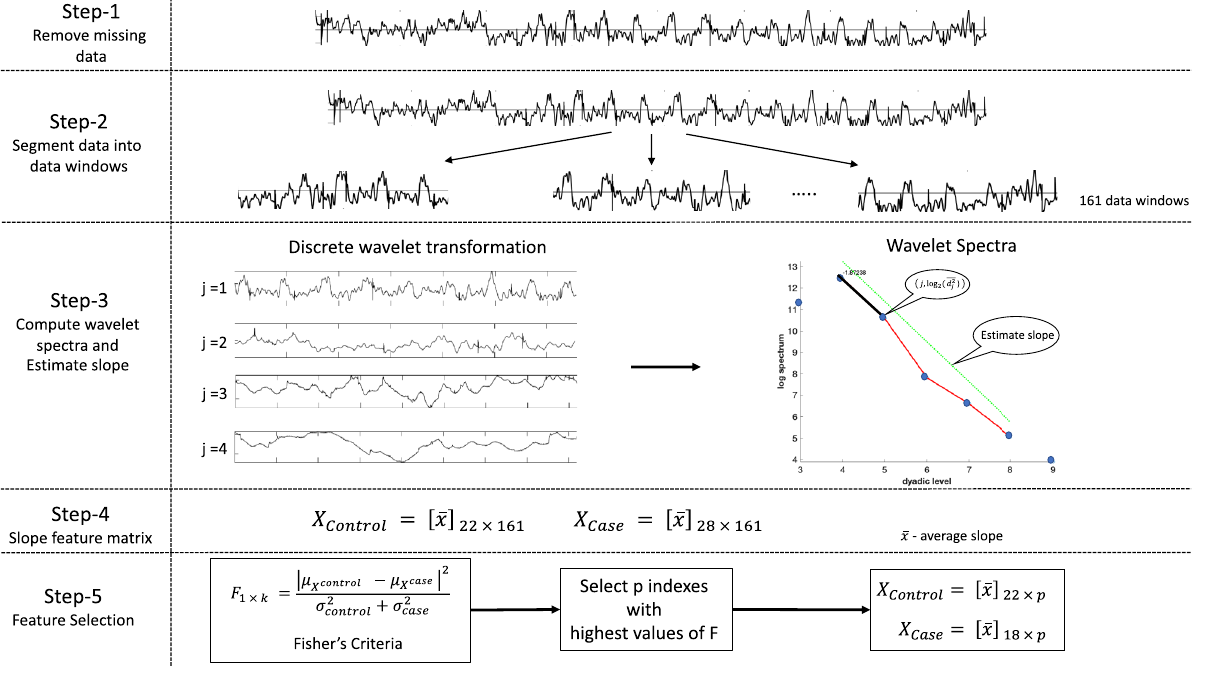
Figure 3. Graphical representation of the data analysis procedure used in this